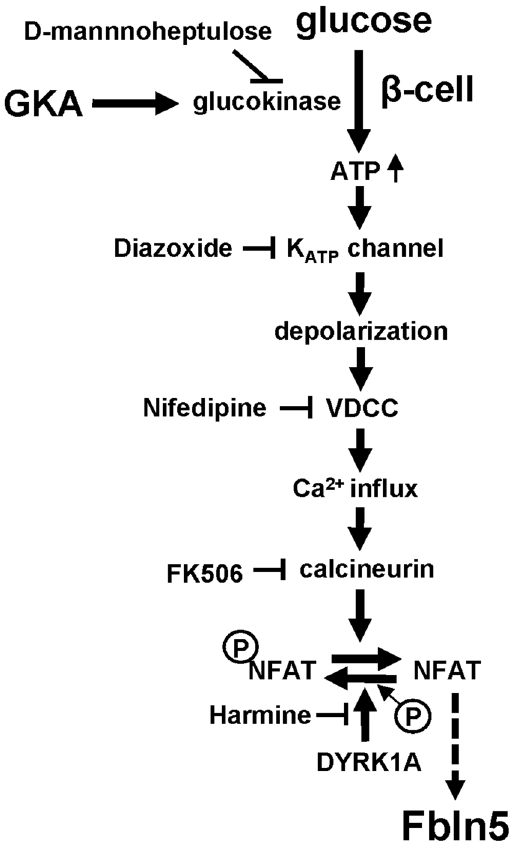
Figure 5. A schematic representation of glucokinase-mediated Fbln5 expression in pancreatic islets. Fbln5 gene expression was induced by glucokinase activation through ambient high glucose concentrations or GKA in pancreatic islets. Depolarization of the membrane accompanied by the closure of K ATP channels, Ca 2 + influx and calcineurin activation are required for this Fbln5 upregulation. A DYRK1A inhibitor, harmine, enhanced Fbln5 expression in the islets induced by glucokinase activation, possibly via NFAT signaling. DYRK1A; dual-specificity tyrosine phosphorylation-regulated kinase 1 A, GKA; glucokinase activator, K ATP channel; ATP-sensitive potassium channel, NFAT; nuclear factor of activated T cells, VDCC; voltage-dependent Ca 2 +